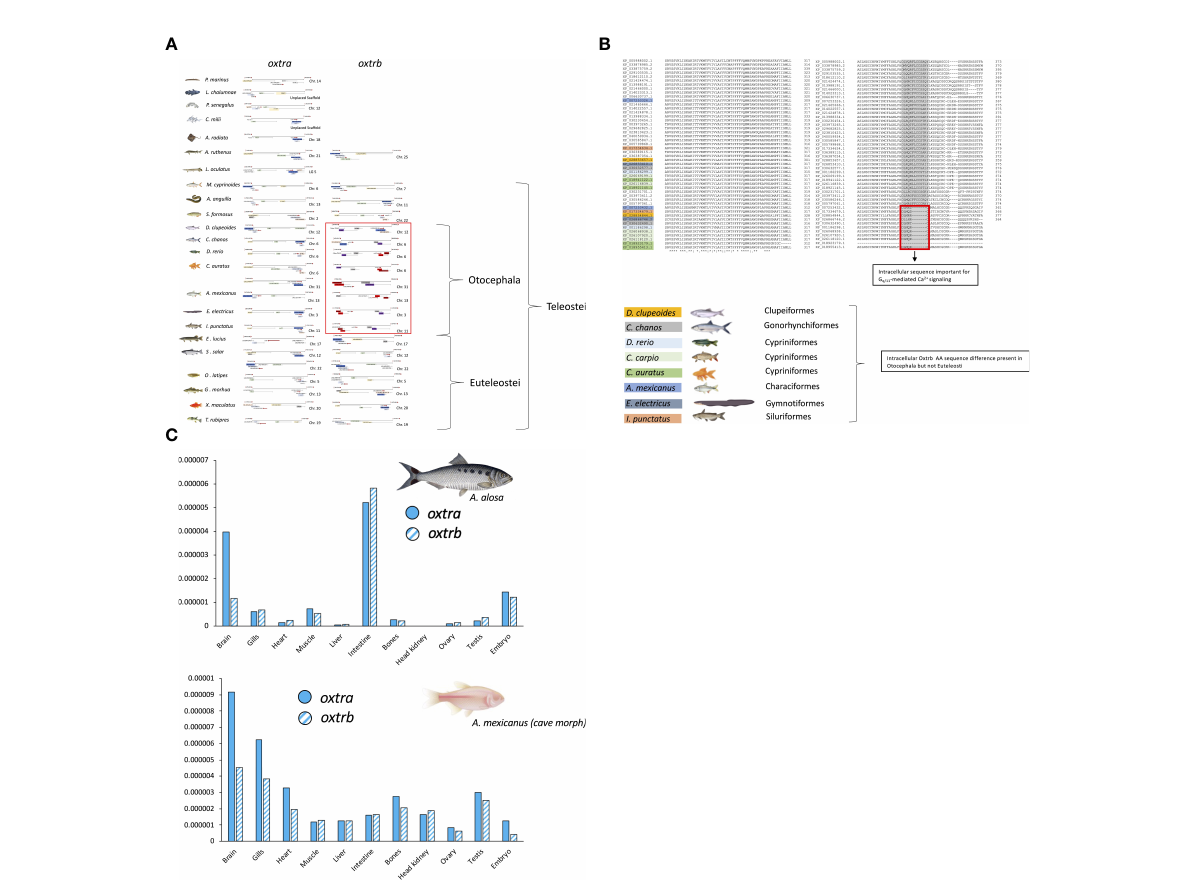
FIGURE 3 Microsynteny analysis (A) , predicted AA sequence alignment (B) and RNA-seq based tissue expression pro fi les (C) of oxtra and oxtrb paralogues in select teleost fi shes. Micro-synteny analysis of oxtr paralogue gene loci was manually conducted on NCBI (www.pubmed.com) derived genome sequences retrieved on June 1 st , 2022, while oxtr gene paralogue sequence-predicted AA sequences were aligned using Clustal Omega (https://www.ebi.ac.uk/Tools/msa/clustalo/). RNA-seq based tissue expression pro fi les of oxtr paralogues was created derived from the Phylo fi sh RNA-seq database queried on June 1 st , 2022